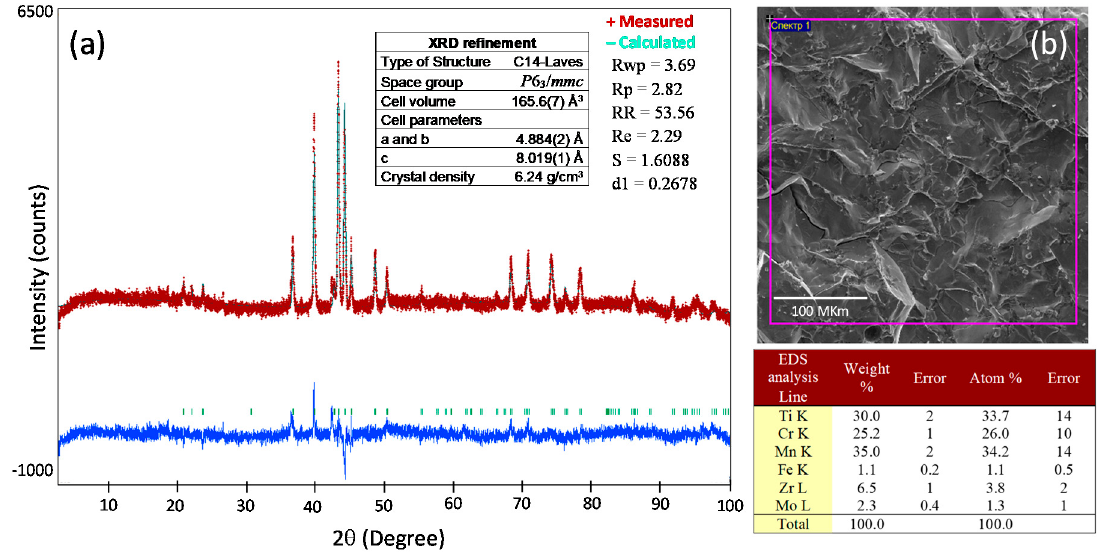
Figure 1. ( a ) XRD analysis and Rietveld refinement, and ( b ) SEM photo of the surface of the TiZr-CrMnMo alloy’s button and corresponding EDS after synthesis.